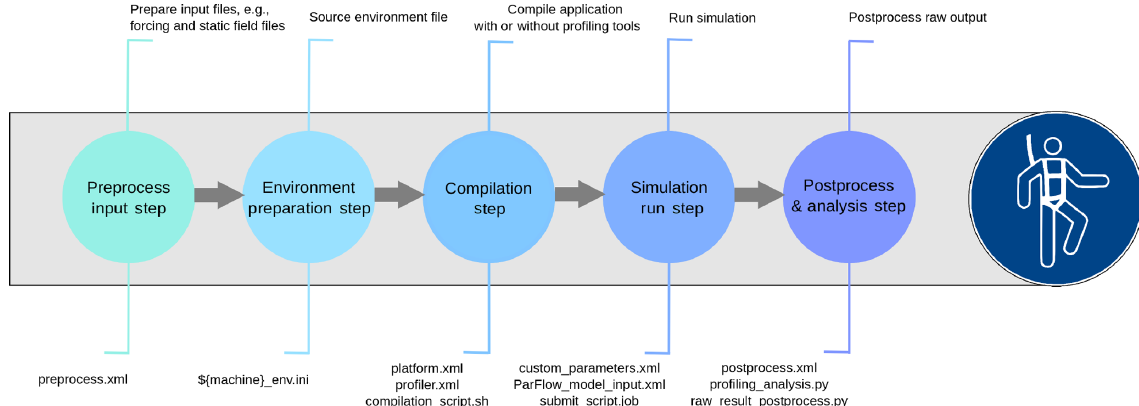
Figure 1. Schematic overview of the modeling chain as supported by our JUBE-based run harness. Each step is annotated with a brief description (at the top) as well as the respective RCF infrastructure (XML files and scripts, at the bottom).